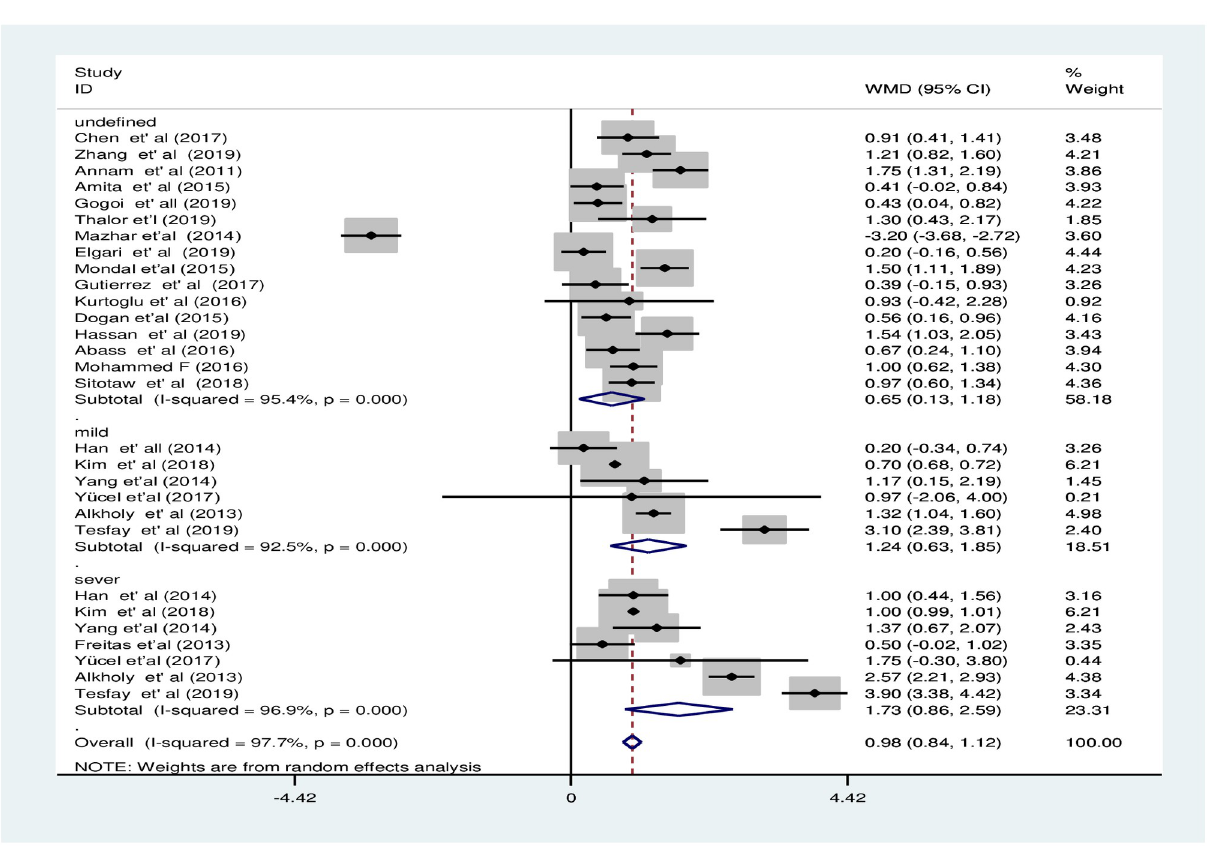
Fig 9. Forest plot of subgroup analysis for the pooled WMD estimate of MPV by PE severity using random effect model.